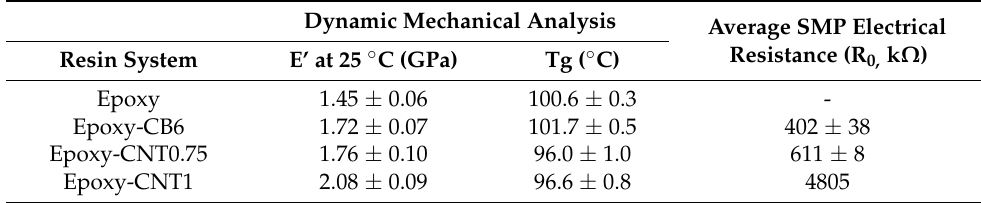
Table 3. DMA results of bulk cured resin and electrical resistance of impregnated SMP for each resin system.